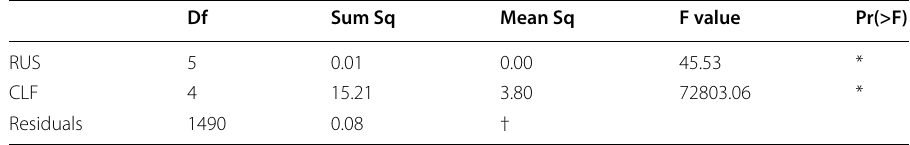
*Indicates the value is less than 1 × 10 − 4 , †indicates the value is less than 1 × 10 − 3